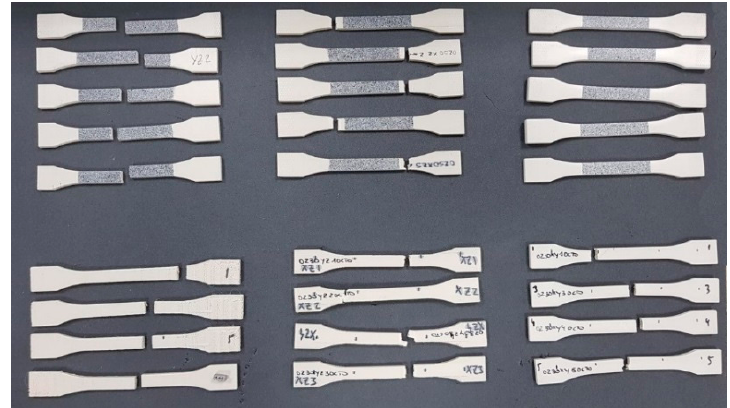
Figure 7. Printed samples for tensile test.